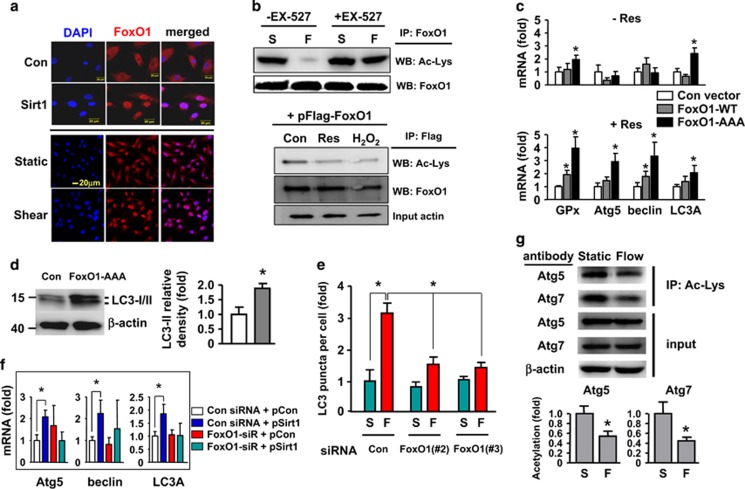
Role of FoxO1 in shear stress- and Sirt1-mediated autophagic response. (a) Immunofluorescence images showing the effects of laminar flow and Sirt1 overexpression on nuclear retention of FoxO1. Nuclei were counter-stained with DAPI (blue). (b) Effects of laminar flow, resveratrol (Res; 10 μM), and H2O2 (300 μM) on the acetylation level of FoxO1 in normal cells (upper) or cells expressing ectopic Flag-FoxO1 (lower). Cell lysates were immunoprecipitated with an anti-FoxO1 or anti-Flag antibody and detected by western blotting with an anti-acetyl lysine (Ac-Lys) antibody. (c) Effects of overexpressing wild type (WT) or the constitutively active form (AAA) of FoxO1 on the expression levels of glutathione peroxidase (GPx), Atg5, beclin-1, and LC3A, in the absence and presence of Res. (d) Overexpression of FoxO1-AAA enhanced the protein level of LC3-II in the presence of Res. (e) Effects of FoxO1 gene silencing with different siRNA sequences on laminar flow-induced autophagic response detected by LC3 immunofluorescence. (f) Effects of FoxO1 siRNA on Sirt1 overexpression (pSirt1)-induced upregulation of Atg5, beclin-1, and LC3A. (g) Laminar flow decreased the acetylation levels of Atg5 and Atg7 detected by immunoprecipitation (IP) with anti-acetyl lysine antibody and western blotting with anti-Atg5 and Atg7 antibodies. Data are mean±S.E.M. *P<0.05, one-way analysis of variance or unpaired t-test, n=4–6. S, static; F, flow; pCon, control plasmid; Res, resveratrol; IP, immunoprecipitation; WT, wild type; GPx, glutathione peroxidase